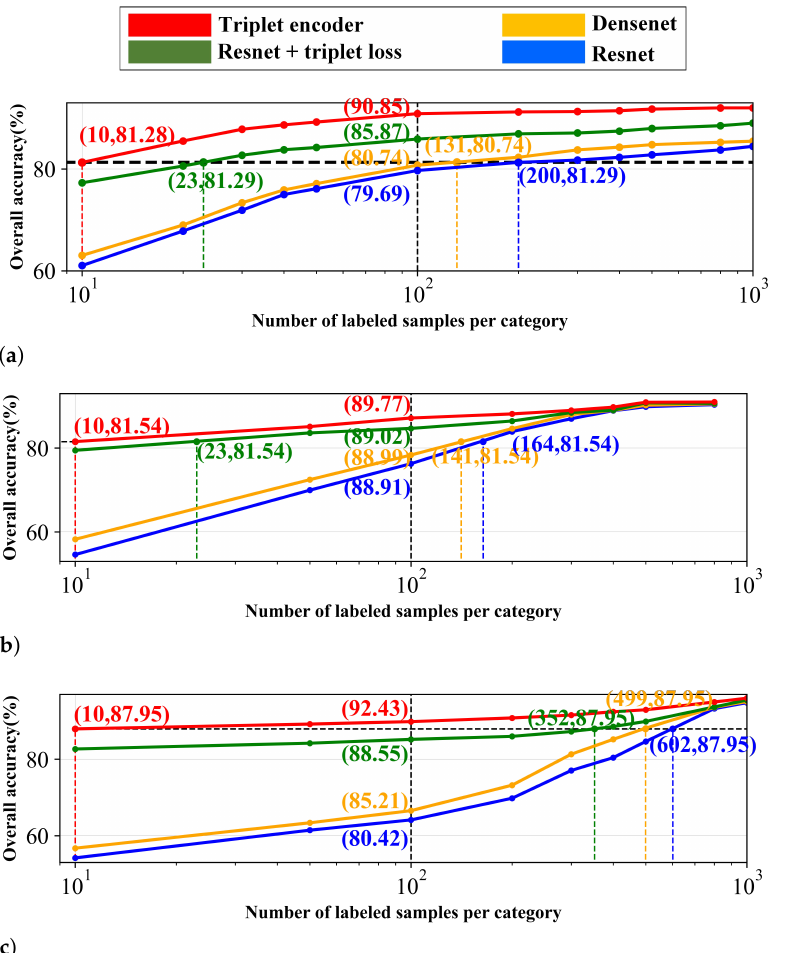
Figure 17. Overall accuracies vary with the number of labeled samples of the three experimental